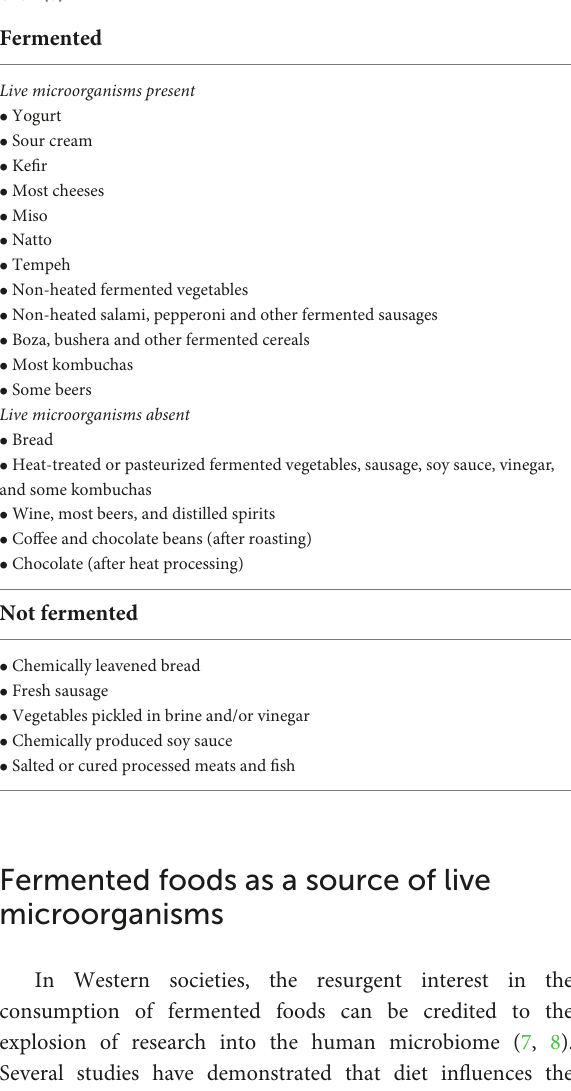
TABLE 1 Classification of fermented foods adapted from Marco et al.